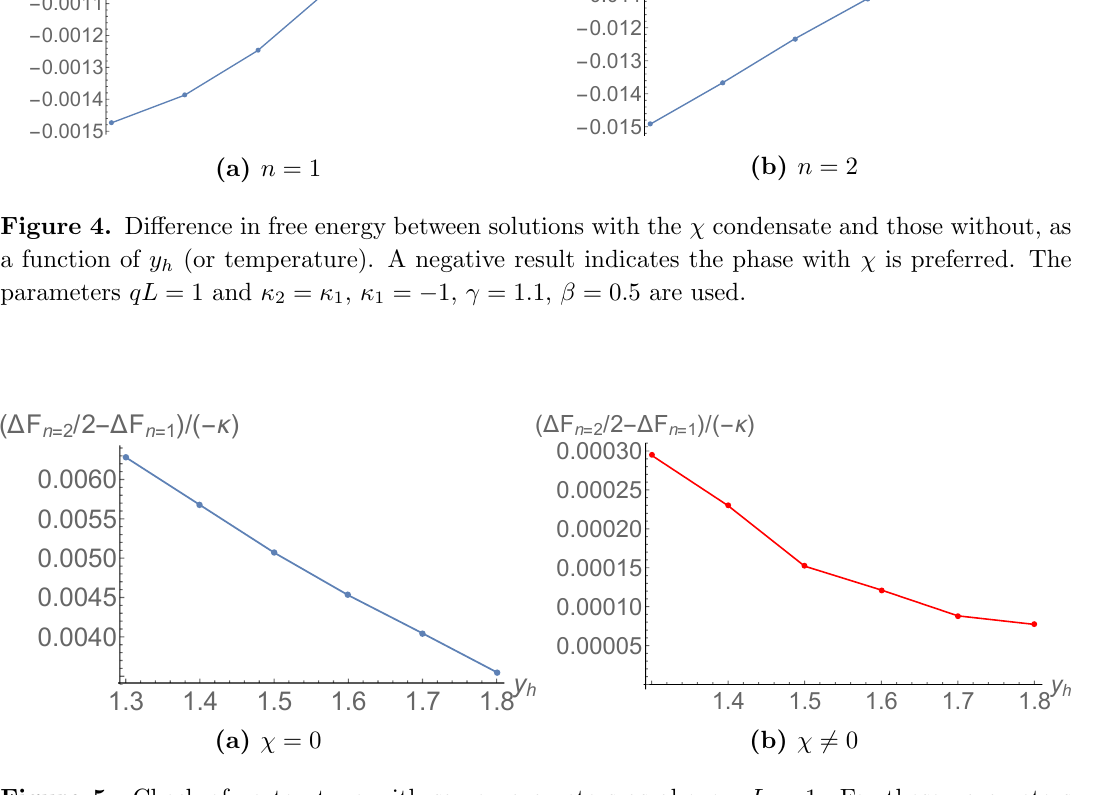
Figure 5. Check of vortex type with same parameters as above, qL = 1. For these parameters these solutions are of type II.